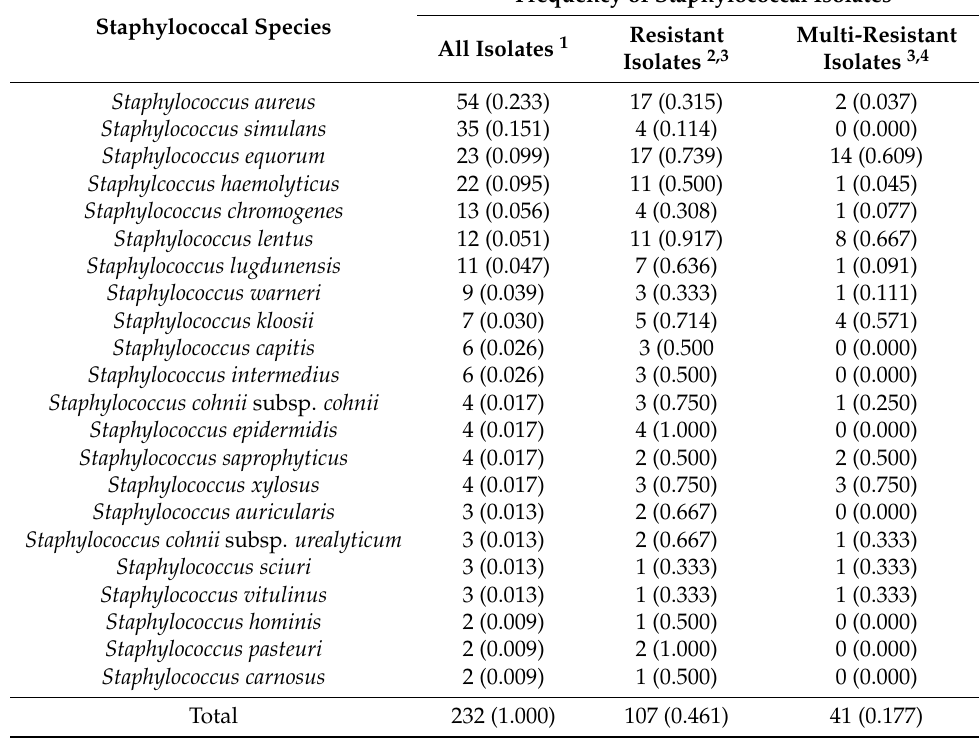
Table 1. Frequency of staphylococcal species recovered from bulk-tank milk of 325 sheep flocks in